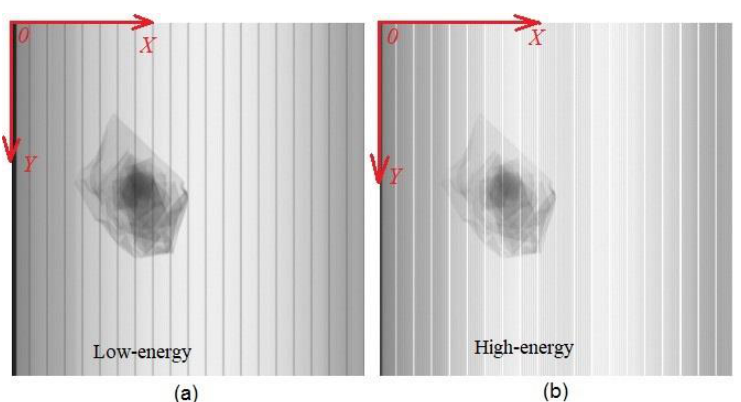
Figure 1. ( a ) Low-energy raw image of a sample with 320 (H, 1.6 mm/pixel) × 320 (V, 1.2 mm/pixel) pixels; ( b ) high-energy raw image of a sample obtained simultaneously with ( a ).